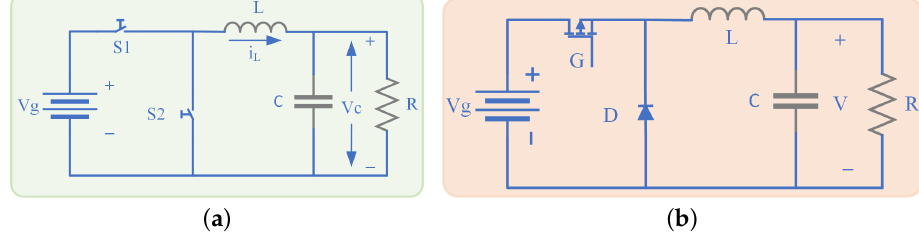
Figure 1. ( a ) Electrical representation of the converter. ( b ) Electrical diagram describing the way a Buck converter is